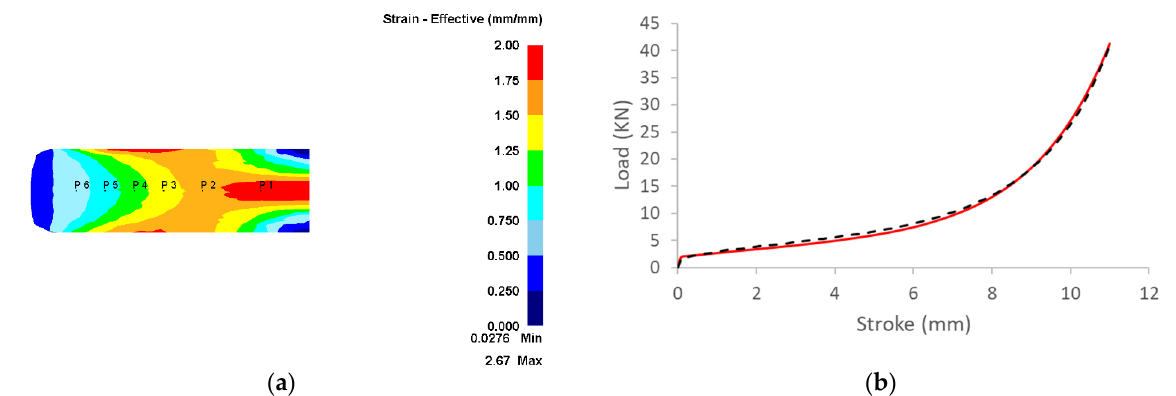
Figure 2. ( a ) Simulated effective strain distribution and ranges of a sectioned double-cone sample compressed at 950 ◦ C with speed of 0.125 mm/s representing nominal strain rate of 0.01/s. P1 to P6 were locations at which microstructure analysis were conducted based on the respective strain ranges; ( b ) Experimental (solid) and simulation (dotted, m = 0.8) obtained load–stroke curves for compression at 950 ◦ C for nominal strain rates of